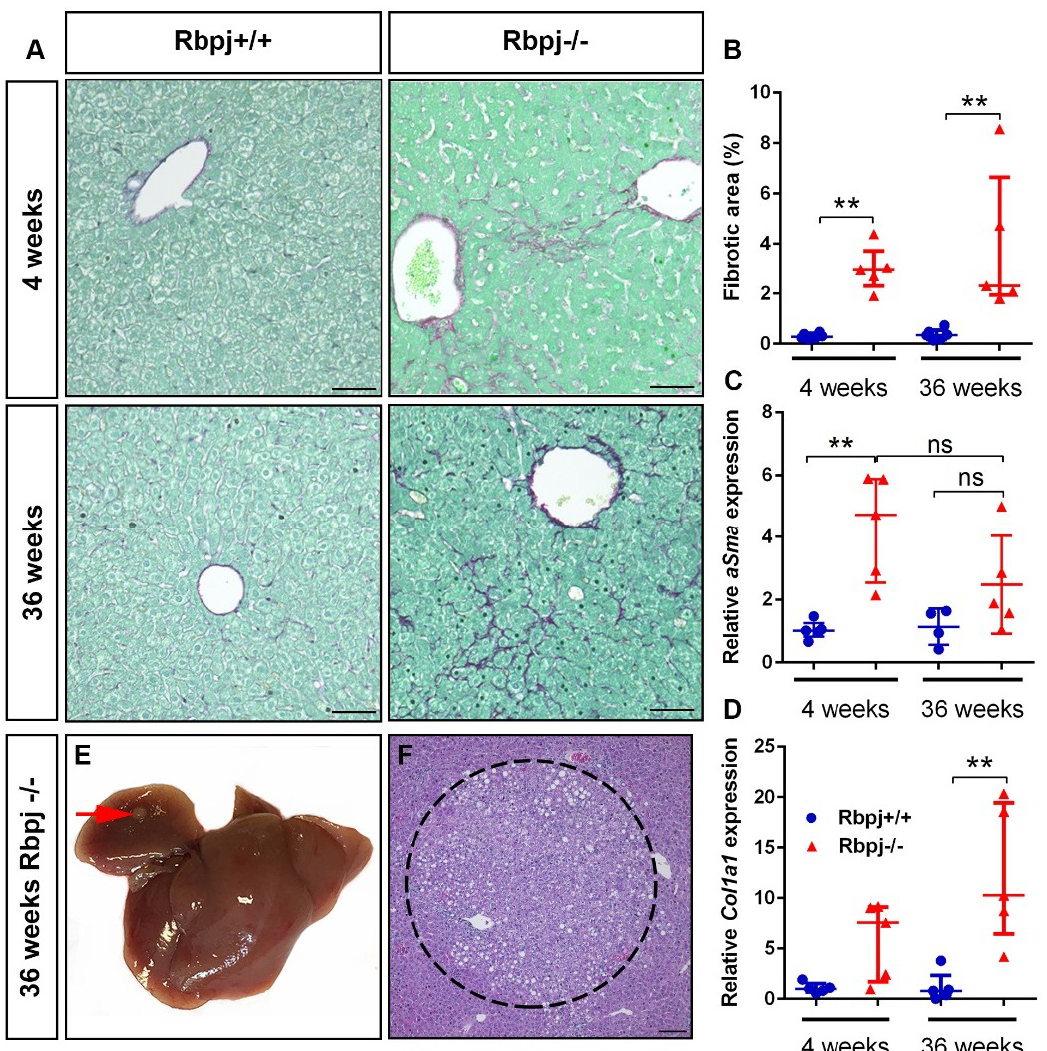
Figure 7. Liver-specific conditional deletion of Rbpj results in liver fibrosis. ( A ) Representative photographs of picro-sirius red staining on liver sections from Rbpj +/+ and Rbpj −/− mice at 4 and 36 weeks of age. ( n = 5–6; scale bar: 100 µm). ( B ) Scatter dot plots showing quantification of fibrotic area determined by picro-sirius red staining ( n = 5–6, ** p ≤ 0.01, Mann–Whitney test (two tailed)). ( C + D ) Relative mRNA expression of αSma ( C ) and Col1a1 ( D ) normalised to RNA polymerase II ( n = 5–6; ** p ≤ 0.01, ns = not significant; Mann–Whitney test (two tailed)). ( E + F ) Macroscopic dysplastic nodule ( E ) of 36-week-old Rbpj −/− liver (red arrow represents macroscopic liver foci) and ( F ) corresponding histology, dysplastic nodule is circled by black dots (scale bar: 100 µm).